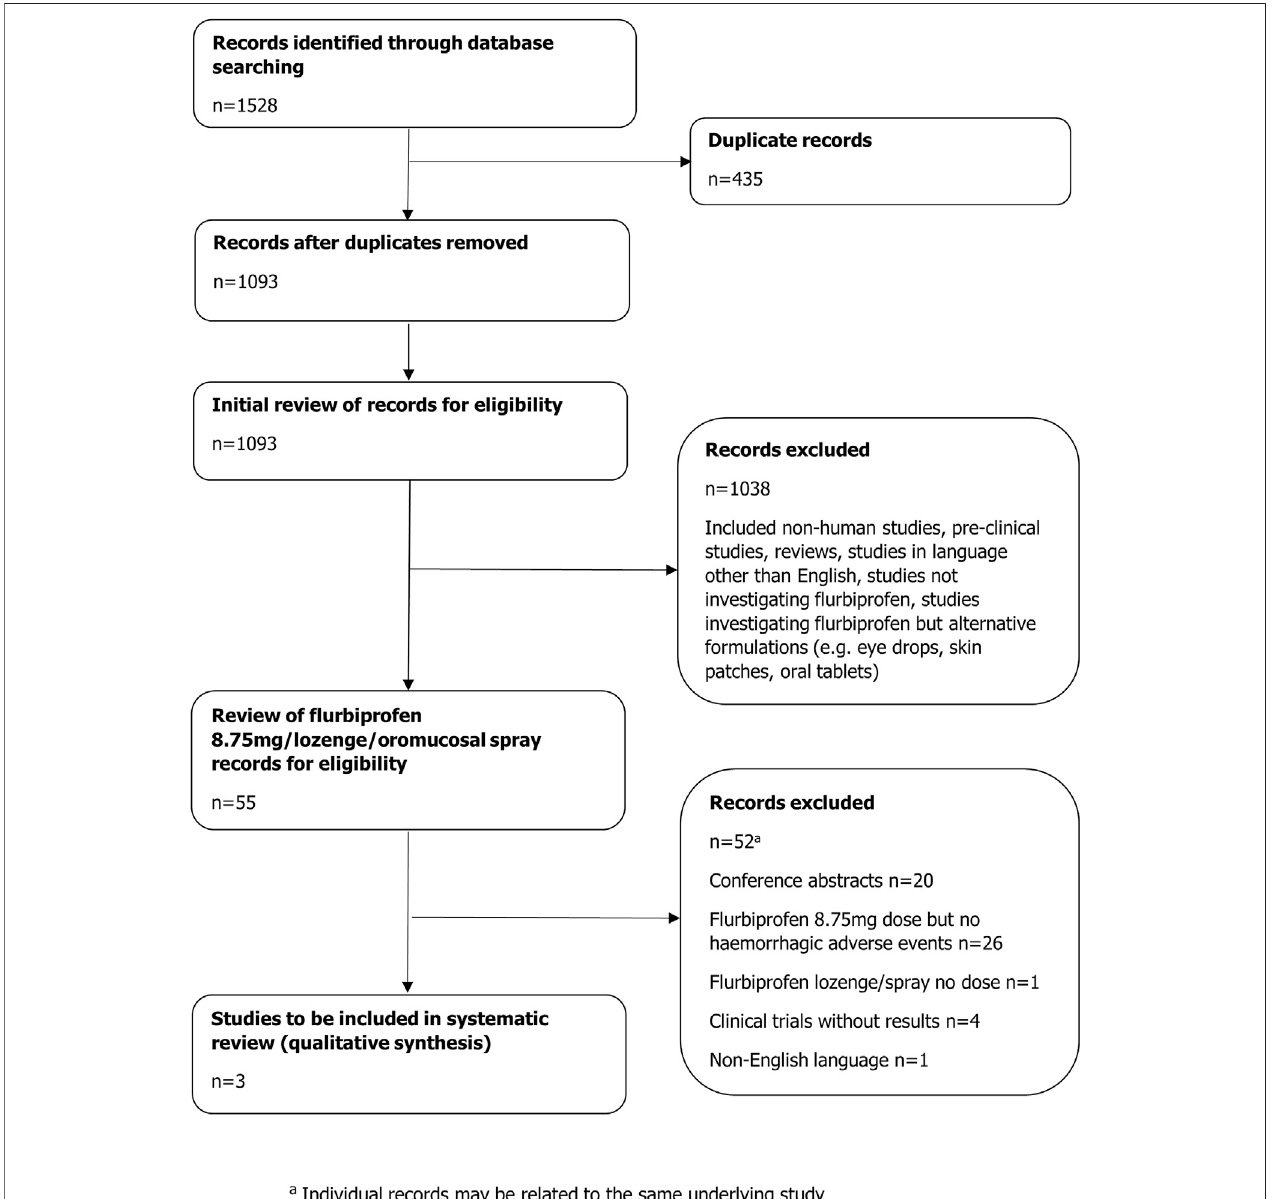
FIGURE 2 | Flow diagram of study